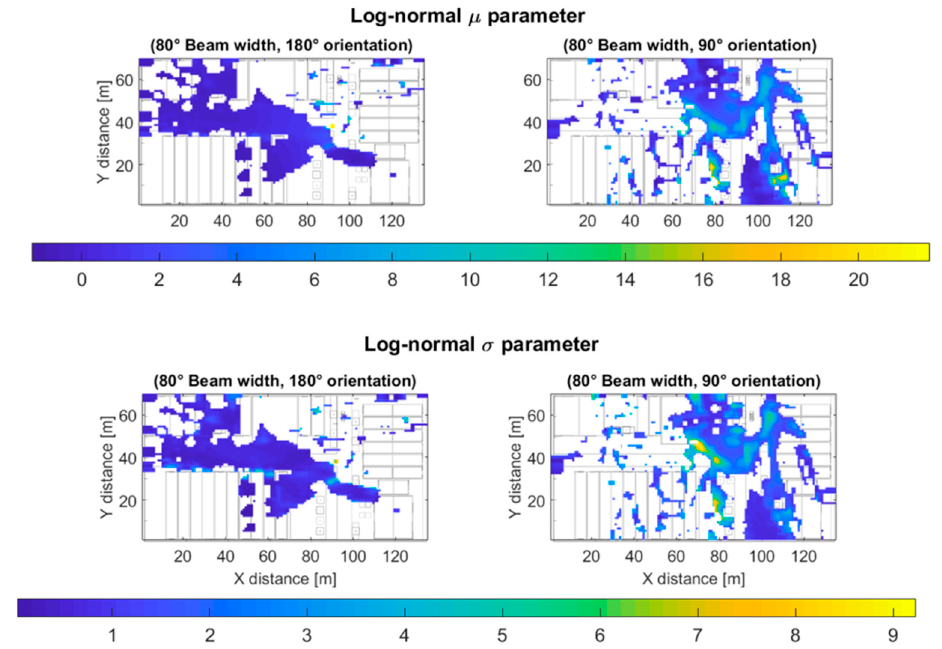
Figure 12. Log-normal distribution’s µ ( top ) and 𝜎 ( bottom ) parameters for the 80° beam width outdoor scenarios.